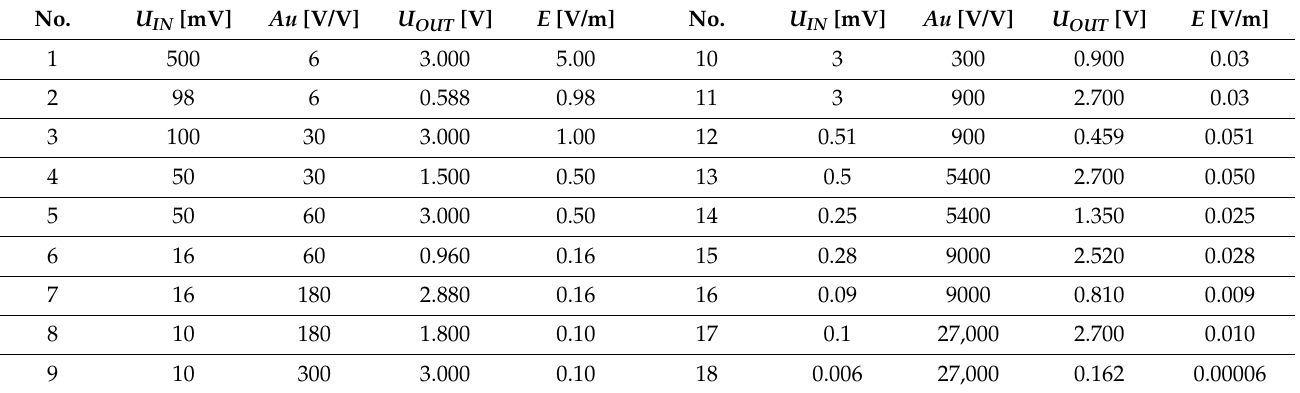
Table 1. Results of measurements of dynamic.